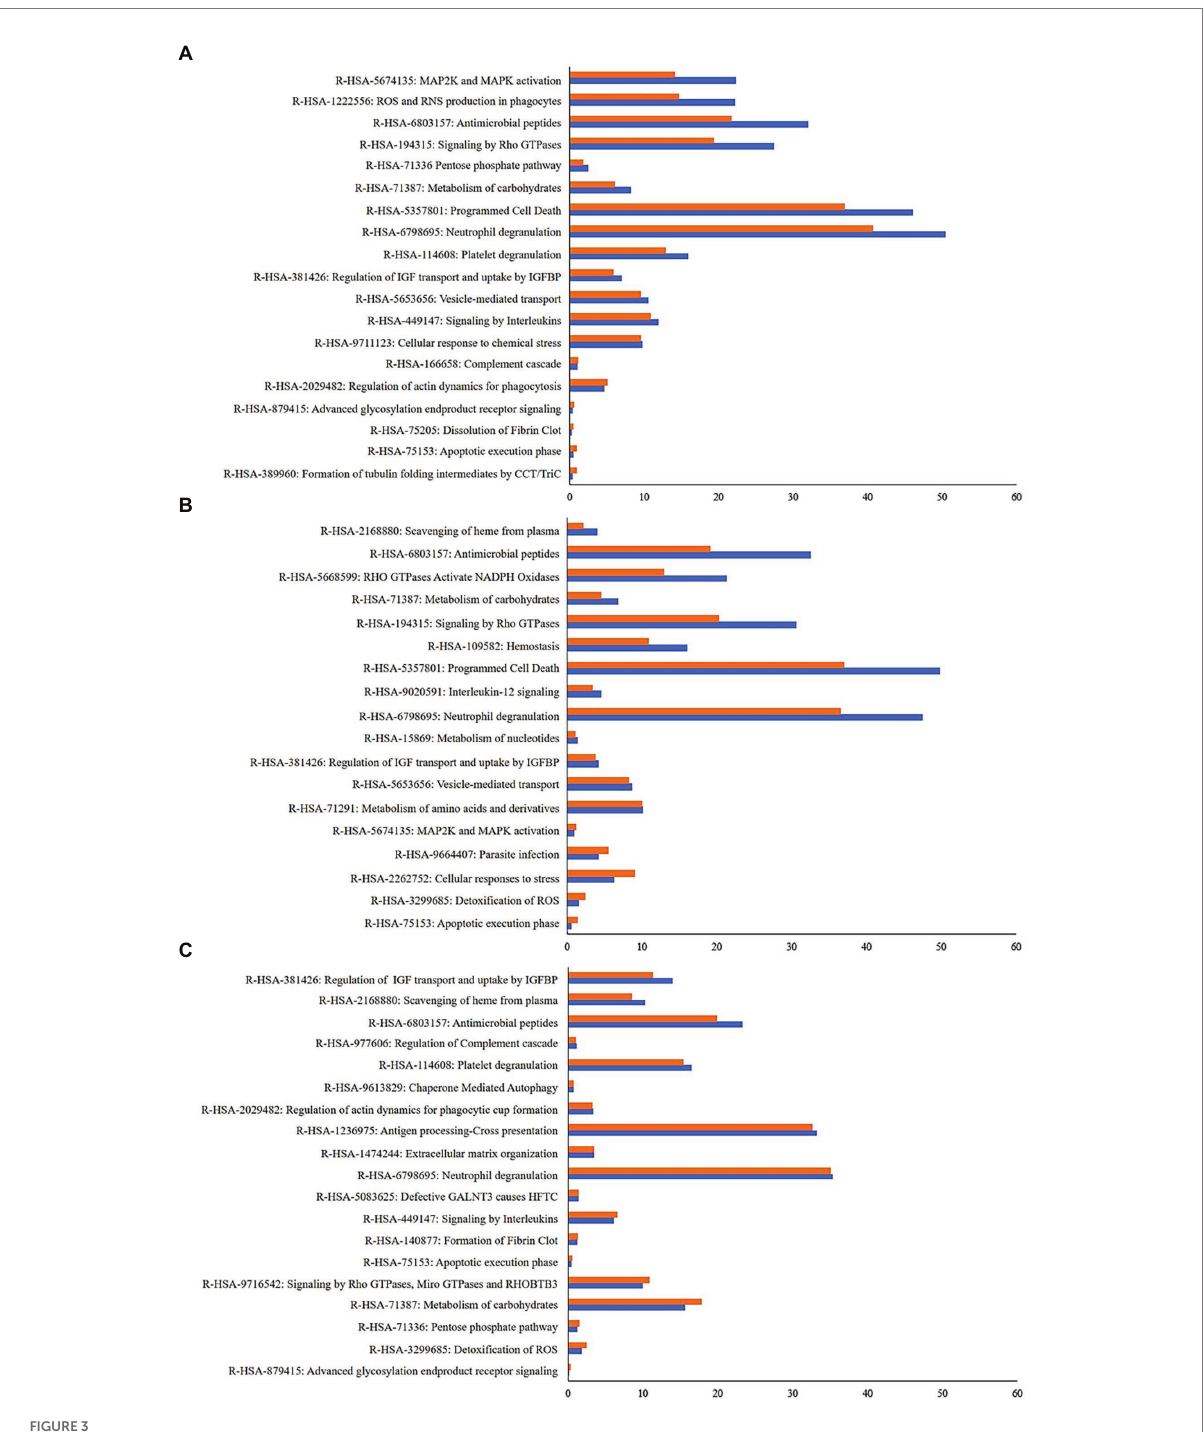
FIGURE 3 Enrichment functional analysis of the human proteins identified in both induced sputum (IS) and spontaneou sputum (SS) samples from the three patients. The Representative Reactome Gene Sets terms identified by annotating human proteins from SS and IS samples are indicated in blue and orange, respectively. Their relative abundance corresponds to the sum of the normalized spectral abundance factor of each human proteins contributing to the functional reactome terms. (A) Patient 1, (B) Patient 2 and (C) Patient